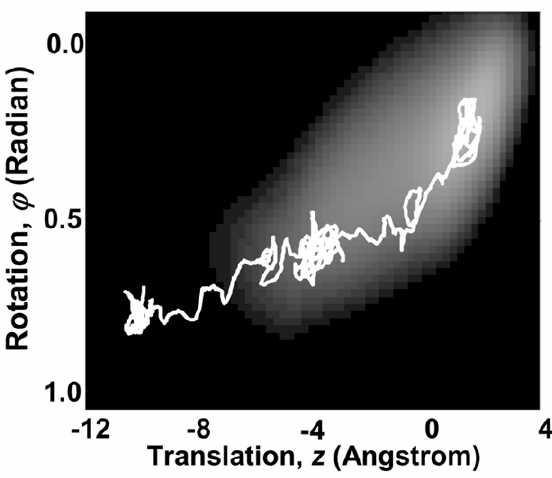
Figure 8. A Motion Trajectory in configuration space in response to a sudden increase in membrane potential from 2 100 mV to + 60 mV. Protein is initially in deep resting state and in response to the change of membrane potential transitions to intermediate resting state, stays there for a while and then transitions to activated state. The associated conformational changes of the voltage sensor are visualized for this motion trajectory in Movie S3.